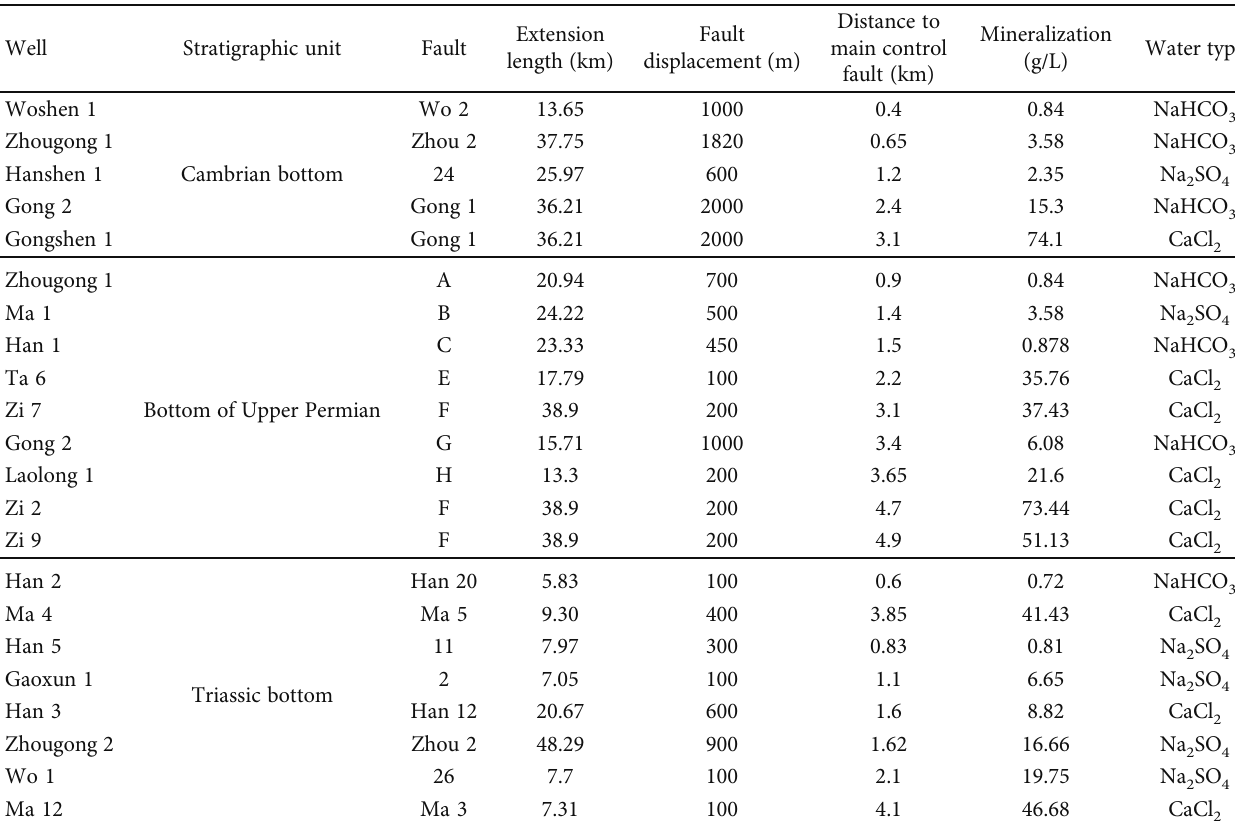
Table 1: Chemical characteristics of shallow and deep formation water in key wells in southwest Sichuan and its relationship with main control faults.